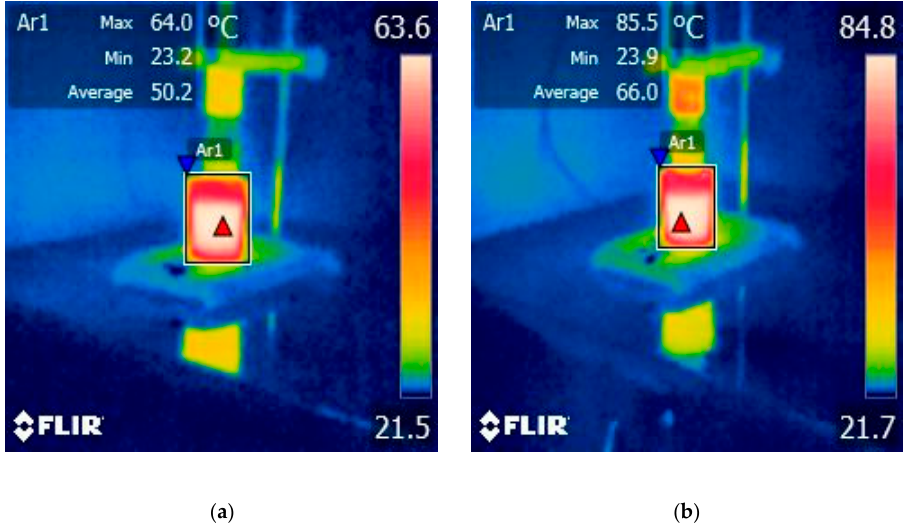
Figure 2. The temperature measured after 10 min of HPU treatment: ( a ) A50%; ( b ) A70%.